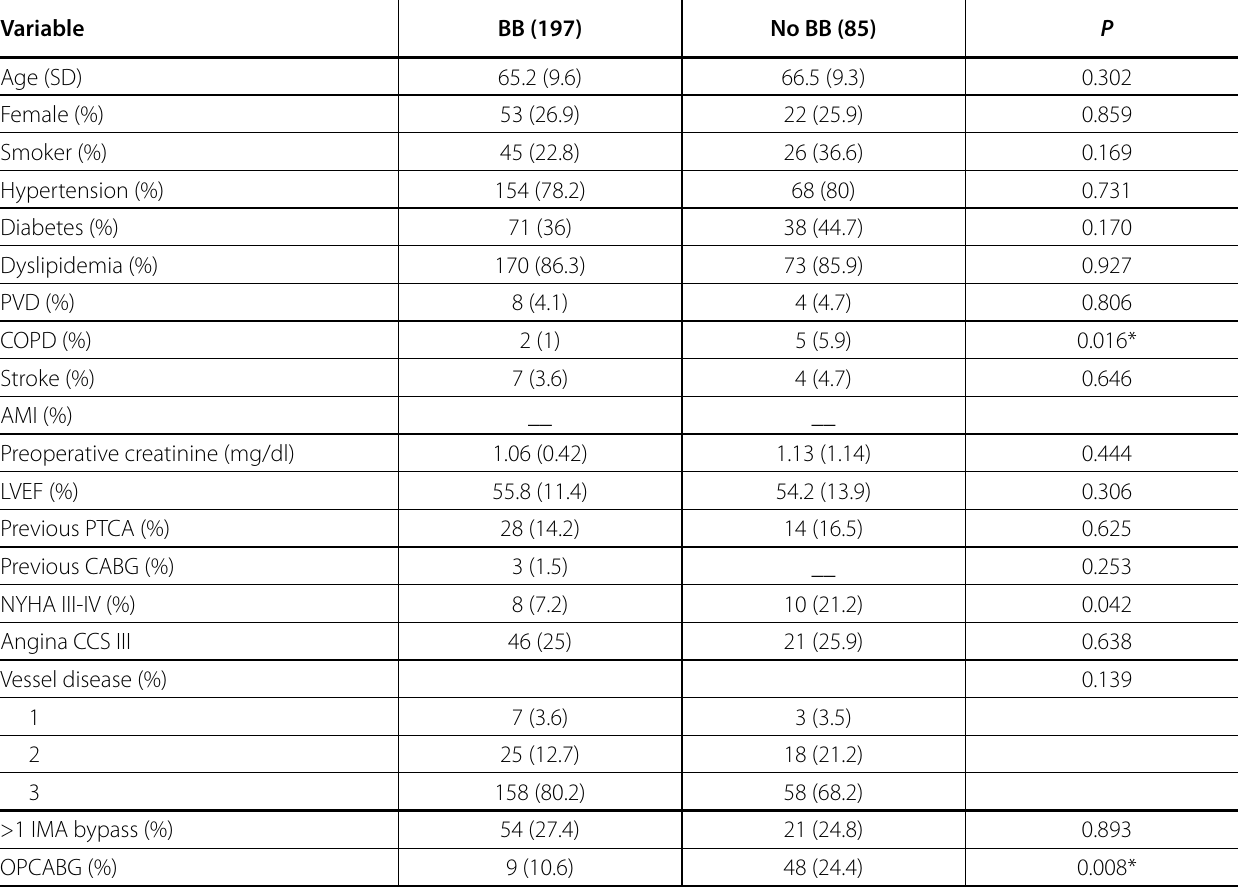
Table 2. Demographic comparison between patients with and without preoperative beta-blockers (n=282).